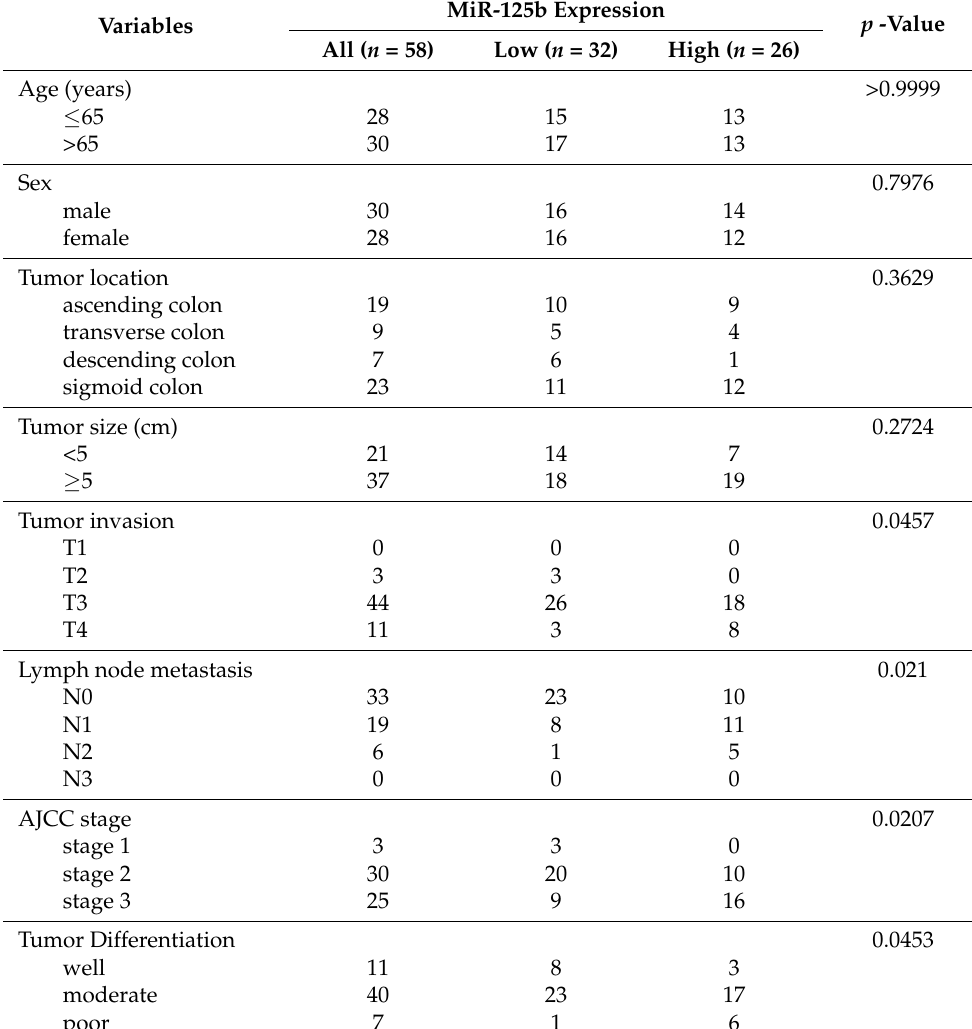
Table 1. Correlation of miR-125b expression with patient clinicopathologic variables in CRC